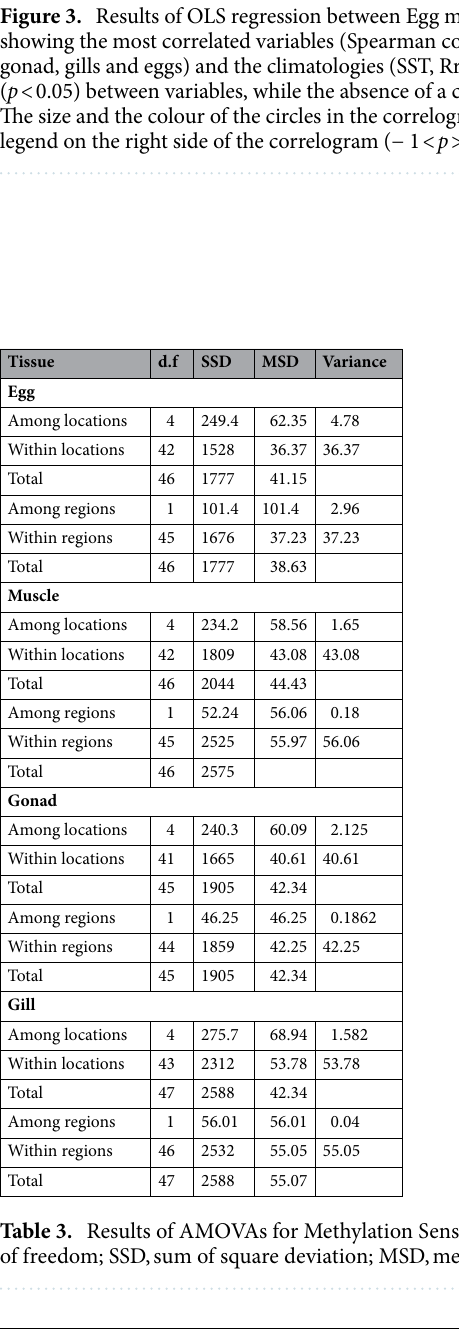
Table 3. Results of AMOVAs for Methylation Sensitive Loci (MSL) for separated tissues and eggs. d.f., degree of freedom; SSD, sum of square deviation; MSD, mean of square deviation; Variance, % of variance explained.